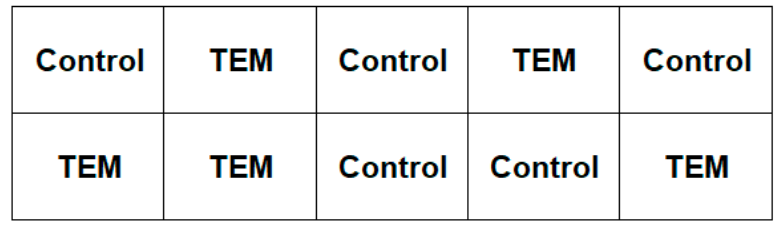
Figure 1. The average monthly air temperature and precipitation during the years of the experiment ( a – e ) and months of the research (I–V).